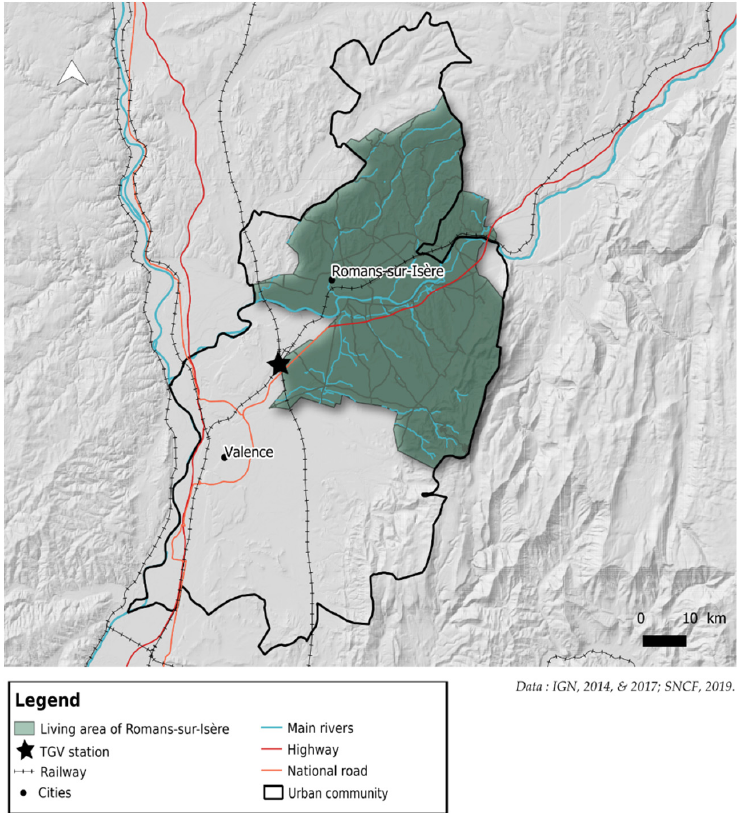
Figure 4. Location detailed of Romans-sur-Isère (source: Authors).